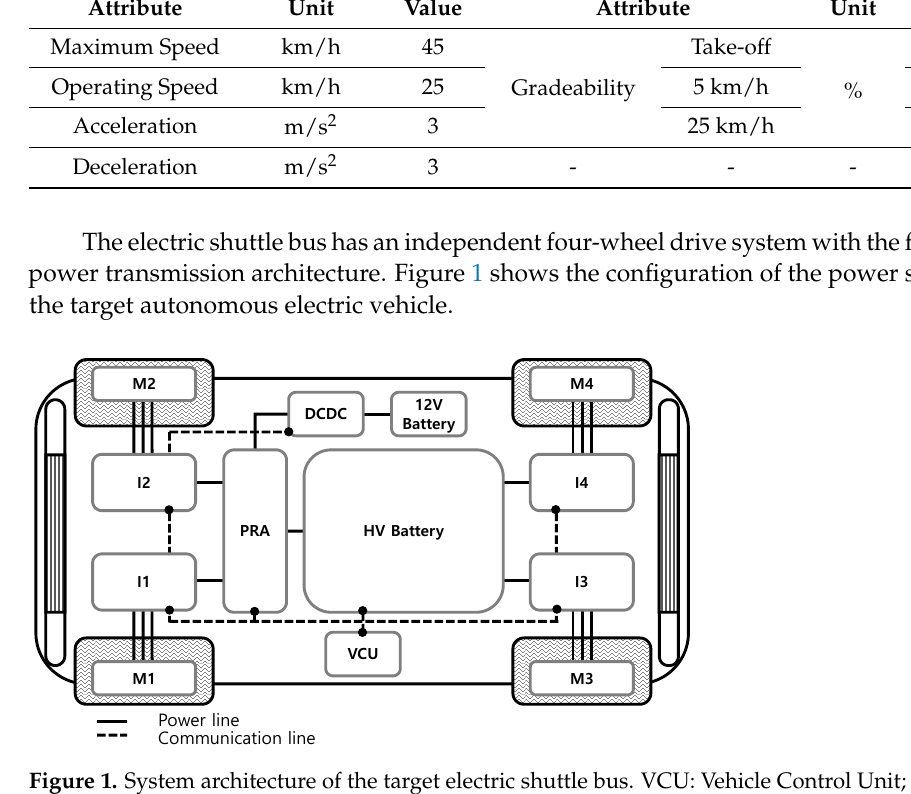
Table 2. Performance requirements of the target vehicle.